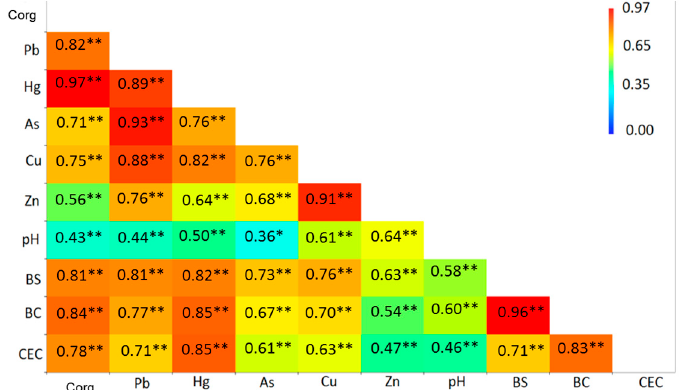
Figure 2. Colour-coded correlation matrix calculated for the soil attributes studied. (Note: ** Correlation is significant at the 0.01 level, * correlation is significant at the 0.05 level). Table 2. Descriptive statistics of the soil parameters studied.